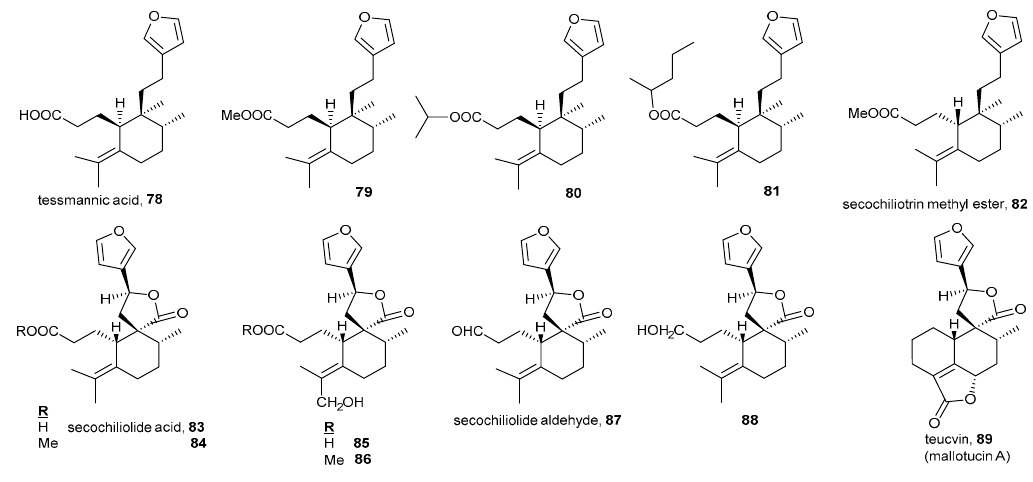
Figure 4. Secohalimanes and 4-enes derivatives. Table 3. Secohalimanes and 4-enes.